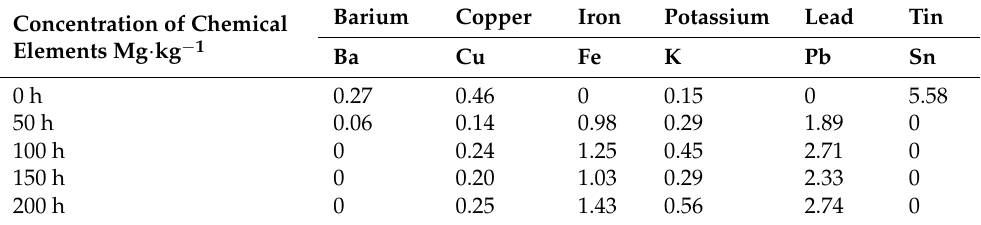
Table 2. Atomic emission spectrometry from the point of view of